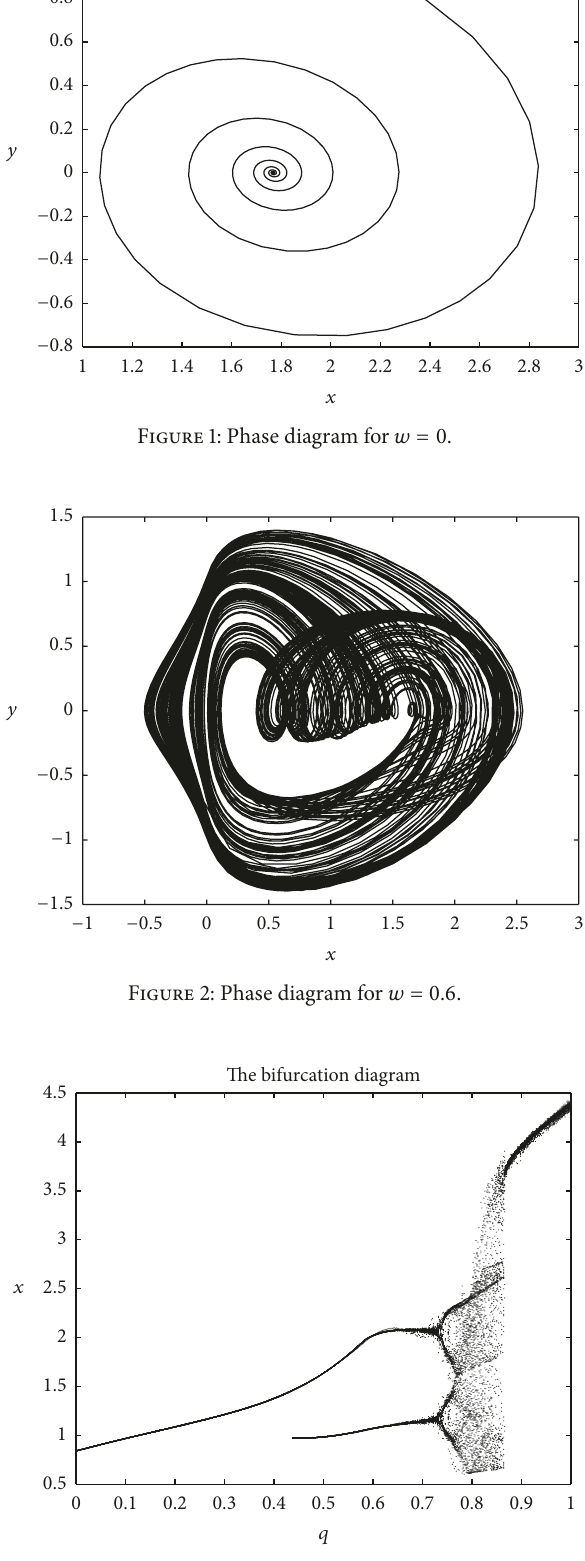
Figure 3: Bifurcation